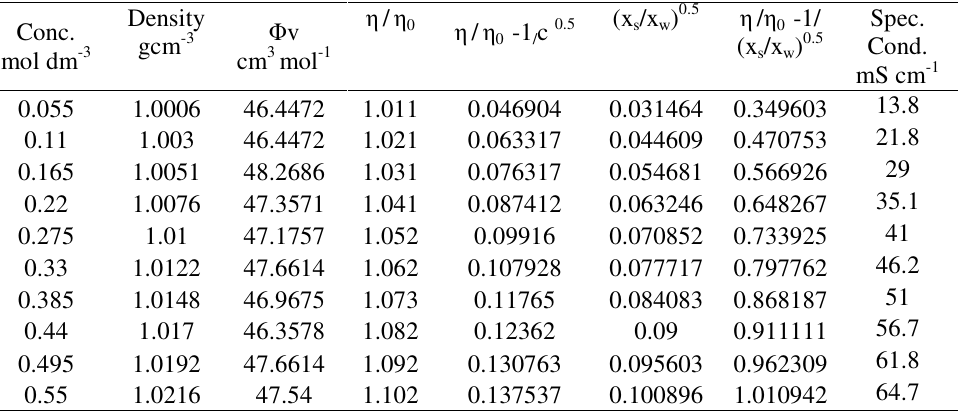
Table 1. Variation in density, specific conductance, and (cid:5) / (cid:5) 0 for different molar concentration of aqueous oxalic acid at 293 K